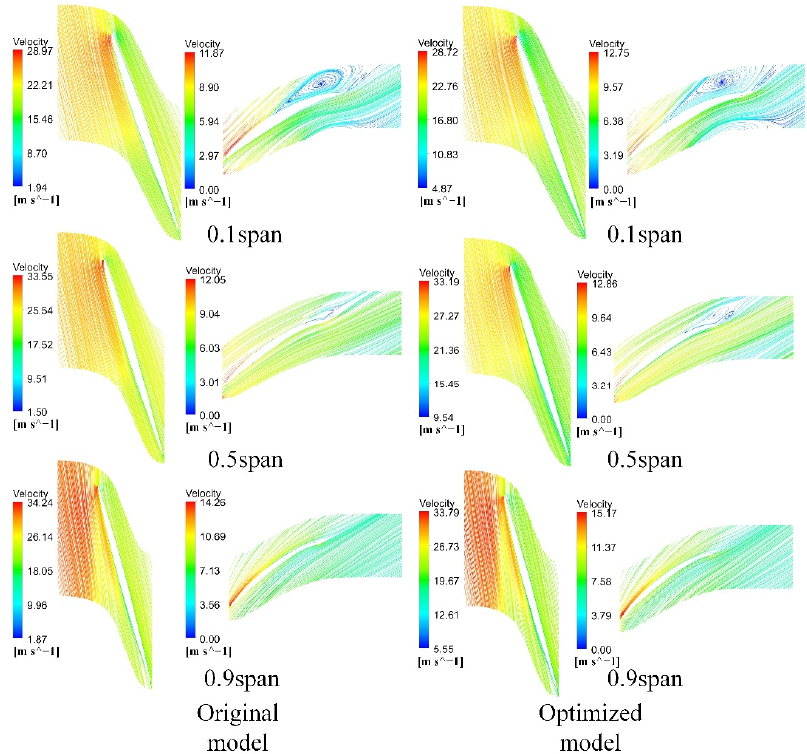
Figure 18. Streamline distribution of impeller and guide vane before and after optimization under the 20%GVF